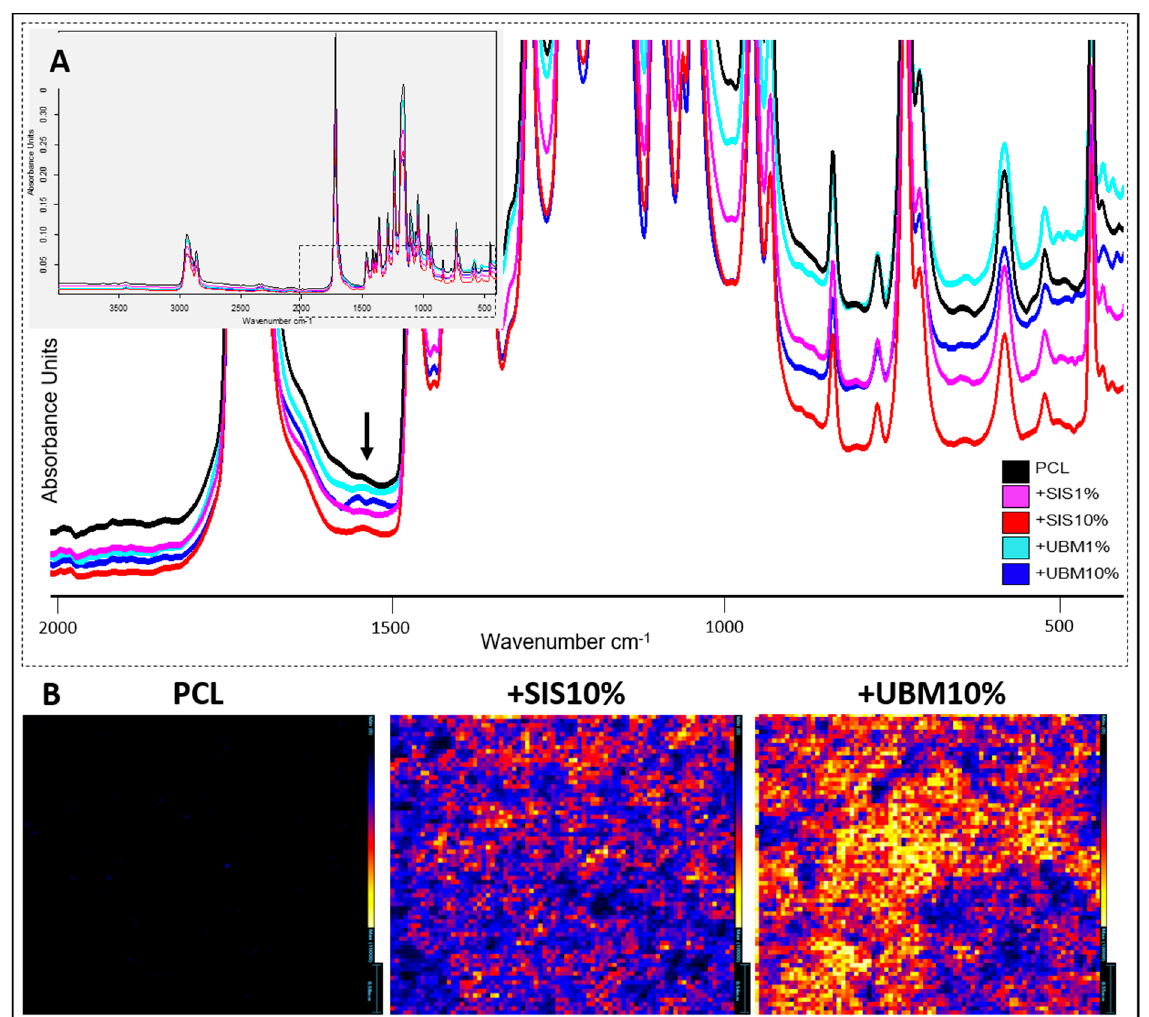
Figure 5. Spectroscopic analysis of electrospun poly( ε -caprolactone) (PCL) scaffolds and following the addition of decellularised tissue powder (small intestinal submucosa (SIS) and urinary bladder matrix (UBM)). ( A ) Fourier transform infra-red spectroscopy with inset demonstrating complete spectra for each group, and magnified view of chemical change at 1590 cm − 1 representative of a primary amine (N-H bend), which was most noticeable for SIS10% and UBM10% groups. ( B ) Imaging-mass spectrometry demonstrating greater ionisation (and even distribution) in SIS10% and UBM10% groups compared to PCL at m/z 523. Maximum number of counts = 10,000. Scale for PCL = 0.58 mm, SIS10% = 0.54 mm, UBM10% = 0.55 mm.